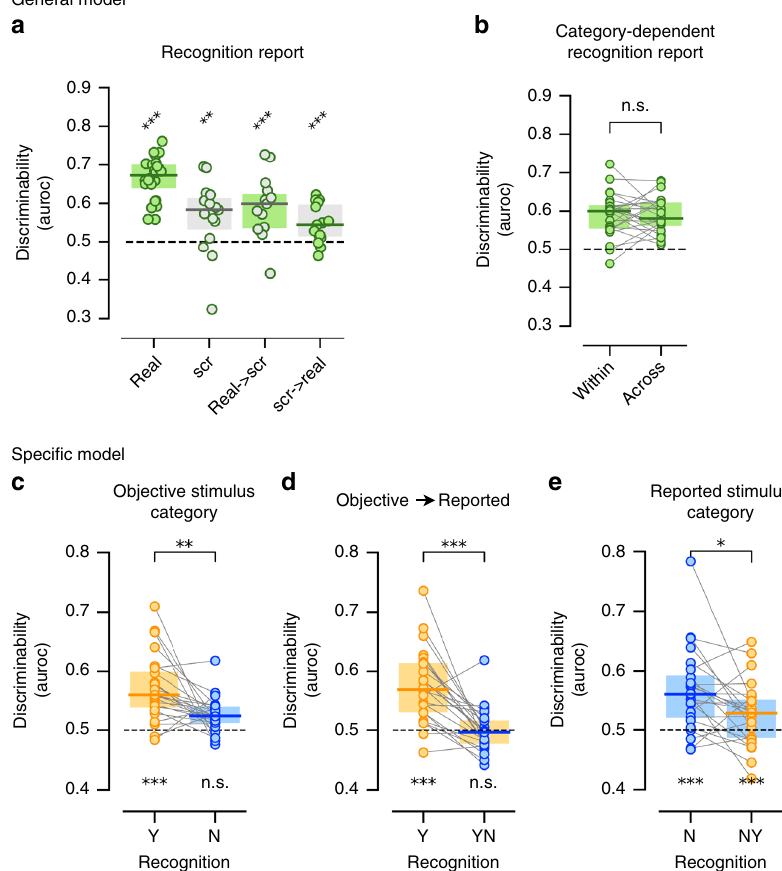
Fig. 2 Pre-stimulus activity contains predictive information about recognition of a forthcoming stimulus. a Discriminability of recognition report (Y/N) calculated using a logistic regression model fi t to pre-stimulus activity patterns, for real and scrambled images separately (1st and 2nd bar, N = 24 and N = 15, respectively). The 3rd and 4th bars show the results of decoding across image type, where the model was fi t using real images and tested using scrambled images and vice versa ( N = 15). b Discriminability of recognition report (Y/N) calculated using a model trained and tested within each objective stimulus category and with the model performance averaged across categories (1st bar) and a model trained on trials from one category and tested on trials from another category and with the performance averaged across category pairs (2nd bar). c Discriminability of the forthcoming objective stimulus category calculated using a logistic regression model fi t to pre-stimulus activity patterns, for recognized and unrecognized trials separately. d Discriminability of a logistic regression model fi t to pre-stimulus activity patterns that was trained to predict objective stimulus category in recognized trials and tested in its ability to predict reported stimulus category in recognized trials (1st bar, using a leave-one-out cross-validation scheme) and unrecognized trials (2nd bar). e Discriminability of the reported stimulus category calculated using a logistic regression model fi t to pre-stimulus activity patterns. 1st bar: trained and tested on unrecognized trials. 2nd bar: trained on unrecognized trials and tested on recognized trials. In b – e , only trials in which real images are presented are used ( N = 24). In all panels, dashed line indicates the theoretical chance level. Whenever training and testing used the same trial group (i.e., not cross-condition decoding), a leave-one-out cross-validation scheme was used. Label permutation was used to assess signi fi